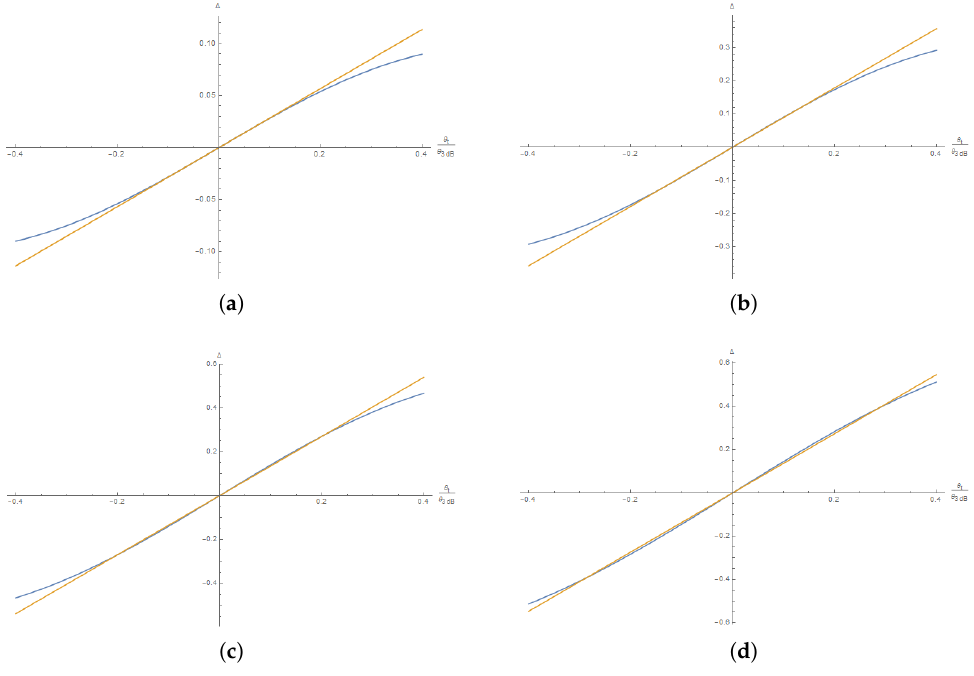
Figure 7. Radiometric deltas extracted numerically (blue) and using the closed approximated formula (yellow) for different values of parameter x